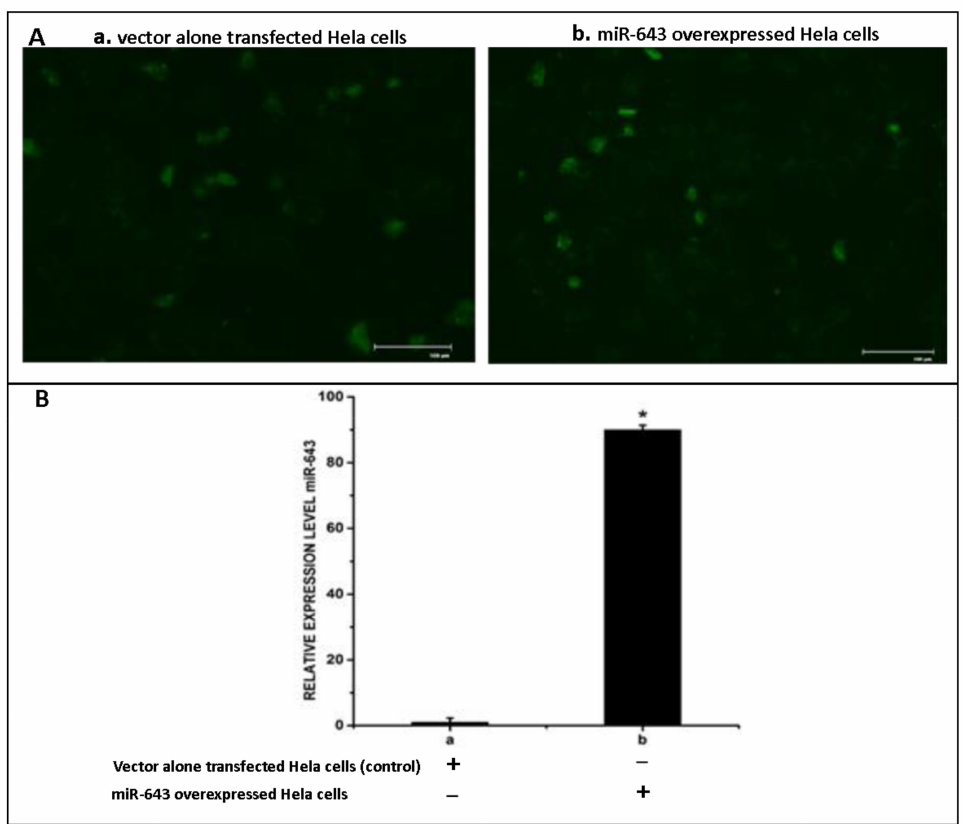
Figure 3. Overexpression of miR-643 in Hela cells. The construct expressing miR-643 was transfected into Hela cells, followed by RT-PCR analysis of miR-643 in transfected cells. ( A ) Microphotographs of cells transfected with a . pCMVmiR (vector control) b . miR-643 construct ( B ) Expression level of miR-643. In (B), a—pCMVmiR (vector control) transfected cells, b—miR-643 overexpressed cells. The mean values of two different experiments ± SEM each performed in triplicate are reported in the graph, p < 0.05. * indicates statistical significance when compared to